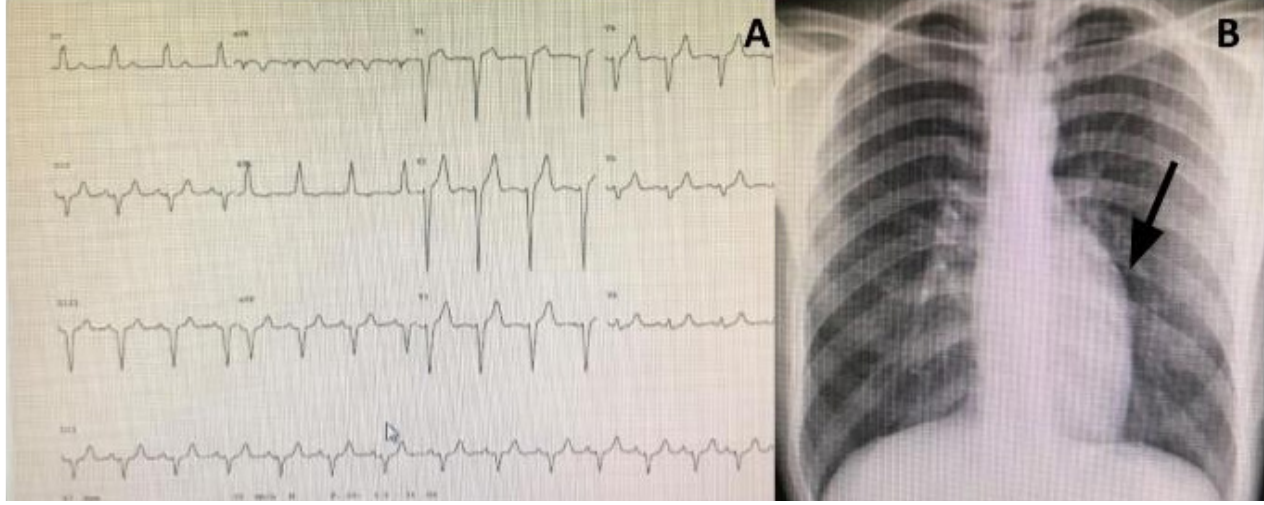
Fig. 1 - Typical electrocardiogram (A) and chest X-ray (B) of an asymptomatic 29-year-old patient with congenitally corrected transposition of the great arteries plus mild tricuspid regurgitation (arrow=humped